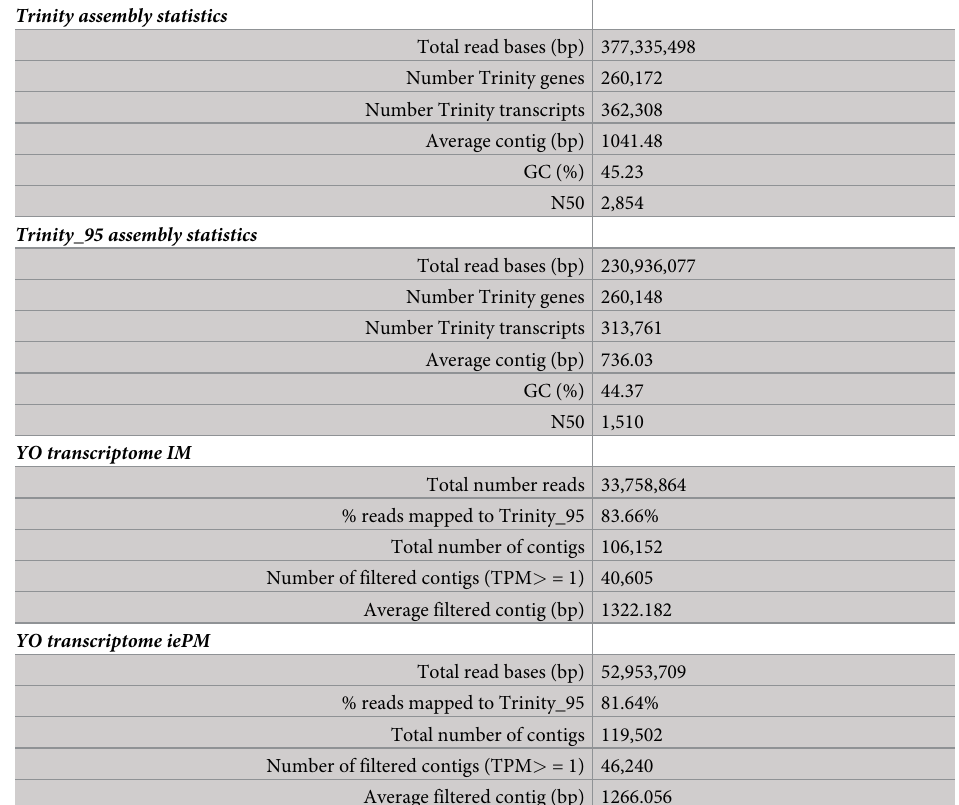
(Table 3). For the YO, 83.66% (IM) and 81.64% (iePM) of the reads were successfully aligned. Based on a transcript per million (TPM) cut off value � 1 using RSEM, the EG transcriptome had the most transcripts with 63,714 contigs followed by the YO at iePM with 46,240 transcripts, 40,605 sequences in the YO at IM (15% and 13% of total assembly respectively) and 29,739 transcripts in the HP (Fig 2). The UpSet plot showed the inter- section between the four transcriptomes. The four tissues had 20,477 sequences in com- mon. In total, the YO at IM and iePM shared 33,609 sequences. EG has the most unique transcripts with 29,829 sequences followed by YO at iePM with 8,813 transcripts, YO at IM with 4,617 contigs and 3,493 transcripts in hepatopancreas. The YO data sets have been submitted o NCBI Sequence Read Archive (SRA) under the BioProject ID PRJNA701676.